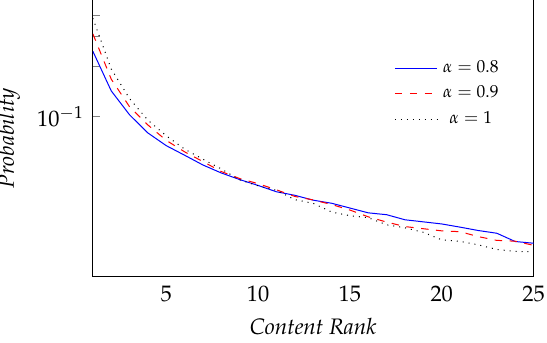
Figure 2. Effect of the popularity skew parameter α on the popularity distribution of a content catalog of 100 items for α = 0.8, 0.9 and 1 for the most popular 25